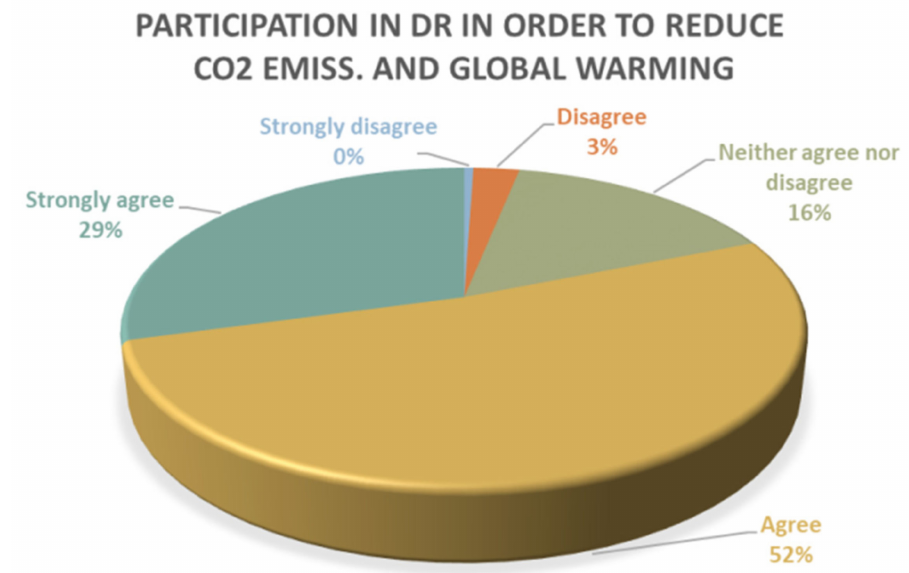
Figure 5. Participation of consumers in DR programs in order to reduce CO 2 and global warming. Source: Authors’ own